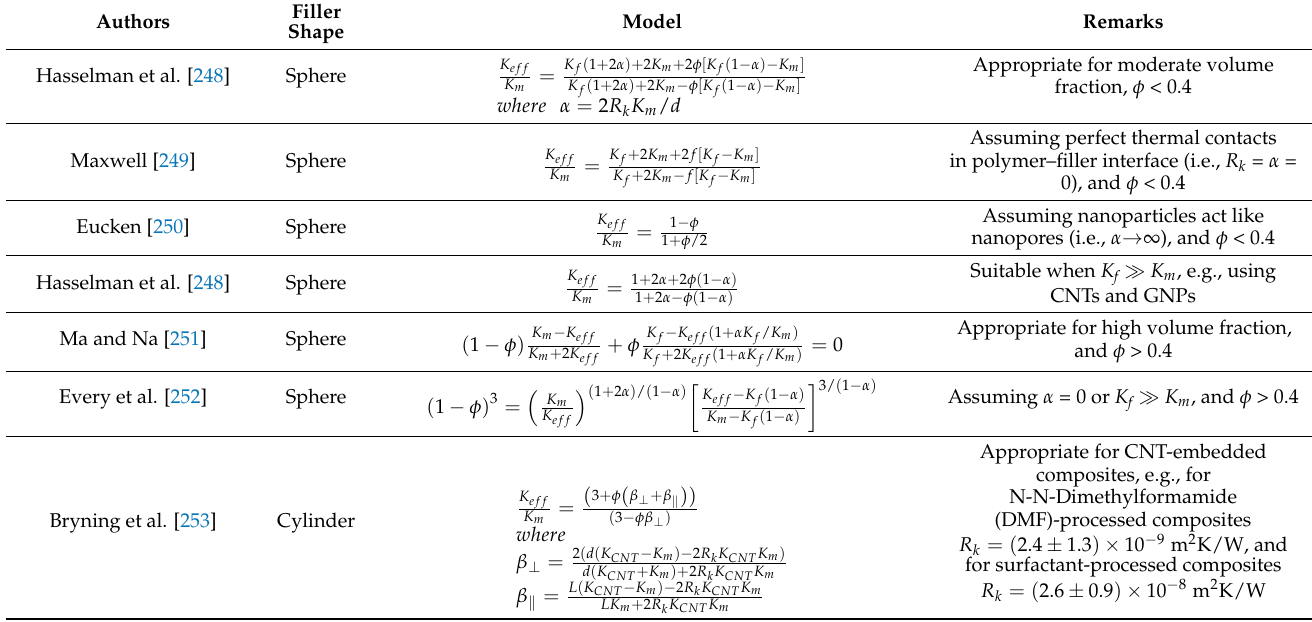
Table 3. Typical models for determining K of filler-embedded